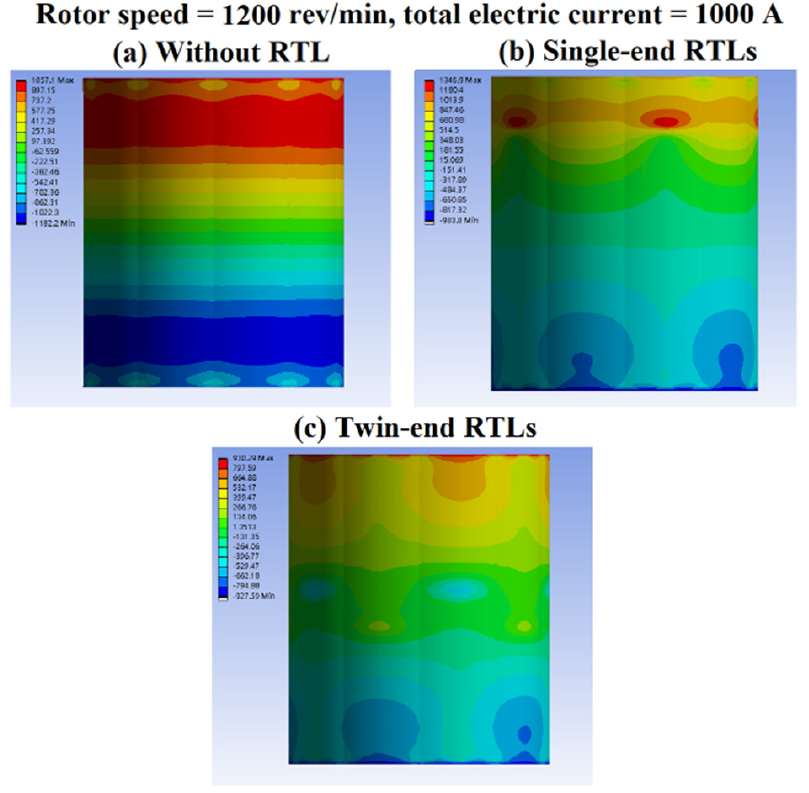
Figure 16. Distribution of axial heat flux (q x ) on the rotor surface in the PMSEMs ( a ) without RTL and with ( b ) single-end RTLs and ( c ) twin-end RTLs at T 0 operating conditions. The average temperatures and axial temperature gradients of the rotor, the stator, and the shaft in the PMSEMs without and with the RTLs are summarized in Table